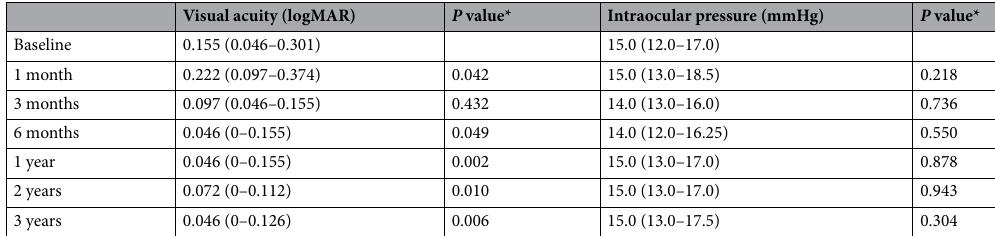
Table 2. Visual acuity and intraocular pressure change after surgery. Data are presented as median (interquartile range). logMAR Logarithm of the minimum angle of resolution. *Wilcoxon signed-rank test (compared with baseline